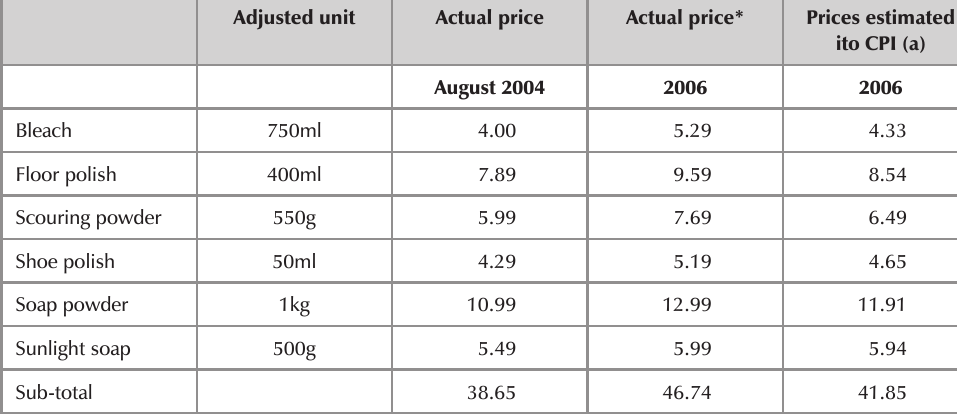
Table 4c Household consumables